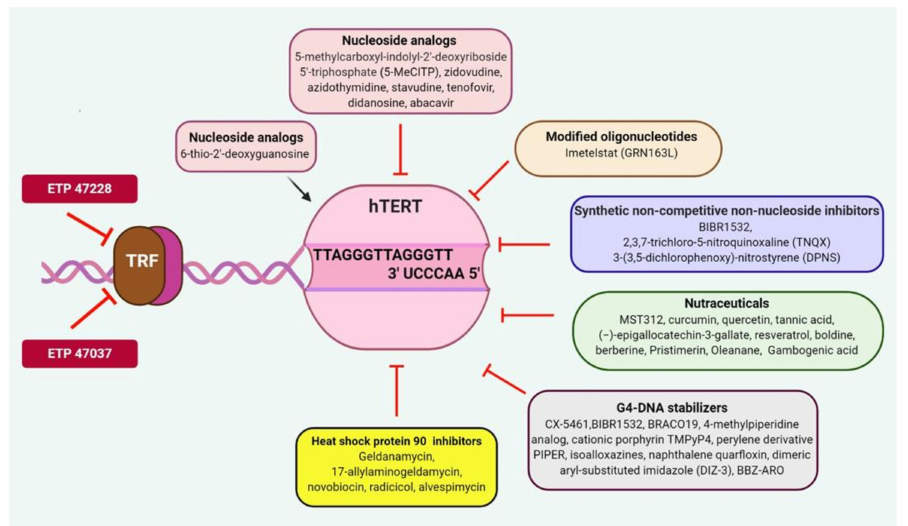
Figure 2. Targeting telomeric components and telomerase as a potential therapeutic approach against human malignancies. TRF1 inhibitors such as ETP-47228, ETP-47037 block the TRF1 binding at the site of telomeres and prevent the formation of a shelterin complex to eradicate cancer cells. Several classes of telomerase inhibitors including nucleoside analogs, oligonucleotides, nonnucleoside, nutraceuticals, Isothiazolone derivatives, G4-DNA